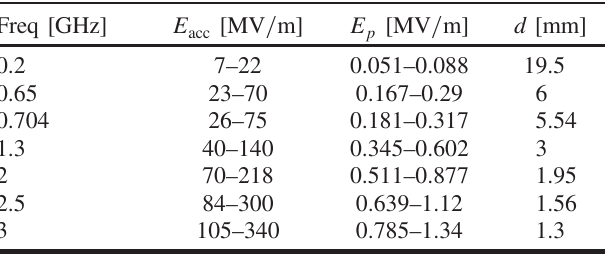
TABLE III. The local peak electric field E p and local gap d of zone 3 MP in scaled TESLA-type cavities. E corresponding acceleration gradient.